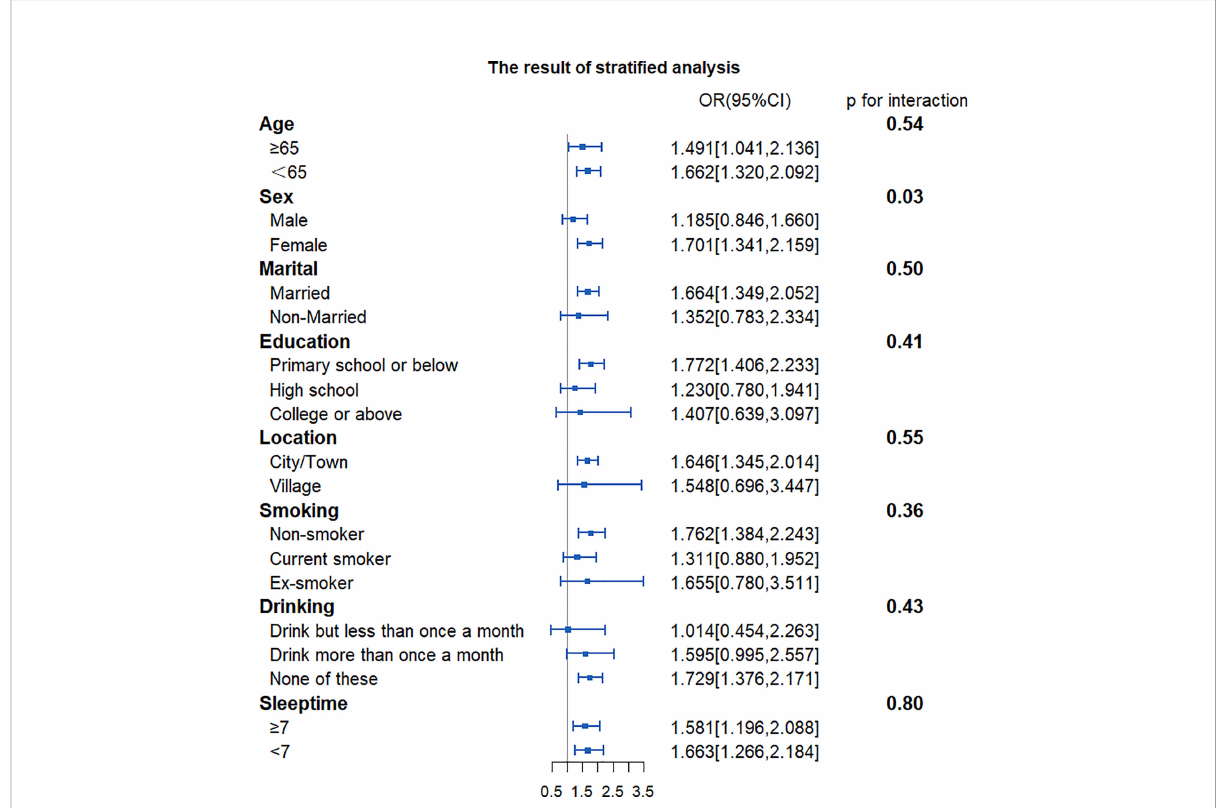
FIGURE 2 Forest plot of strati fi ed analysis of the association of CVAI with the risk of T2DM. The plot shows that there were signi fi cant interactions between CVAI and sex. OR, odds ratio; CI, con fi dence intervals; CVAI, Chinese visceral adiposity index; T2DM, type 2 diabetes